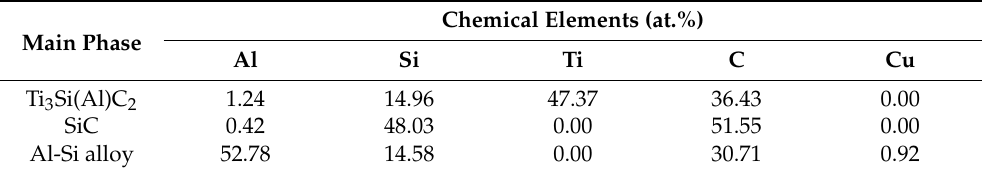
Figure 10. SEM images of SiC base ceramic, ( a ) the raw SiC ceramic, ( b , c ) SiC ceramic infiltrated with Al base alloy at 900 °C for 6 h, ( d , e ) EDS line scanning results of Line 1 and Line 2. ( f – k ) TEM and EDS mapping images of sample infiltrated at 900 °C for 6 h. Table 1. EDS analysis of the different microstructures in Figure 10c.